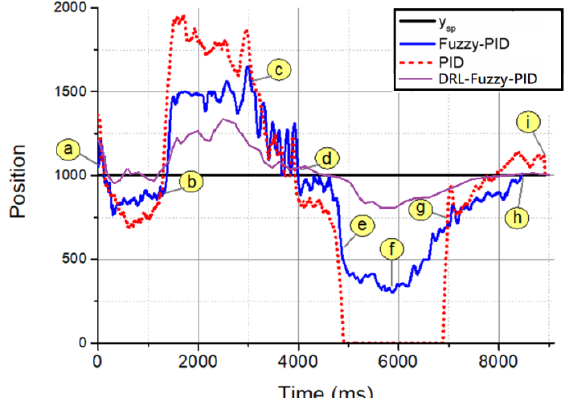
Figure 14. Position comparison diagram of PID, Fuzzy-PID, and DRL-Fuzzy-PID controller in site tracking control. Table 5. Site tracking results of conventional PID, Fuzzy-PID, and DRL-Fuzzy-PID control. Controller